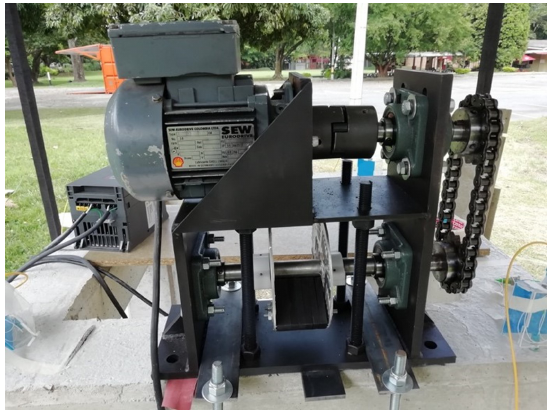
Figure 5. Mechanical shaker.